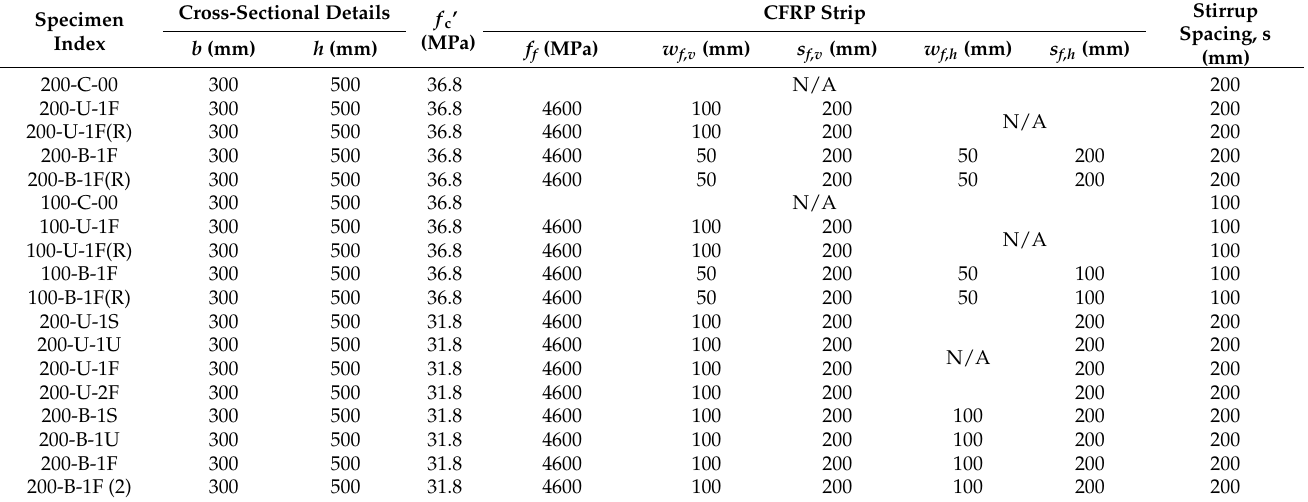
Table 1. Test specimen